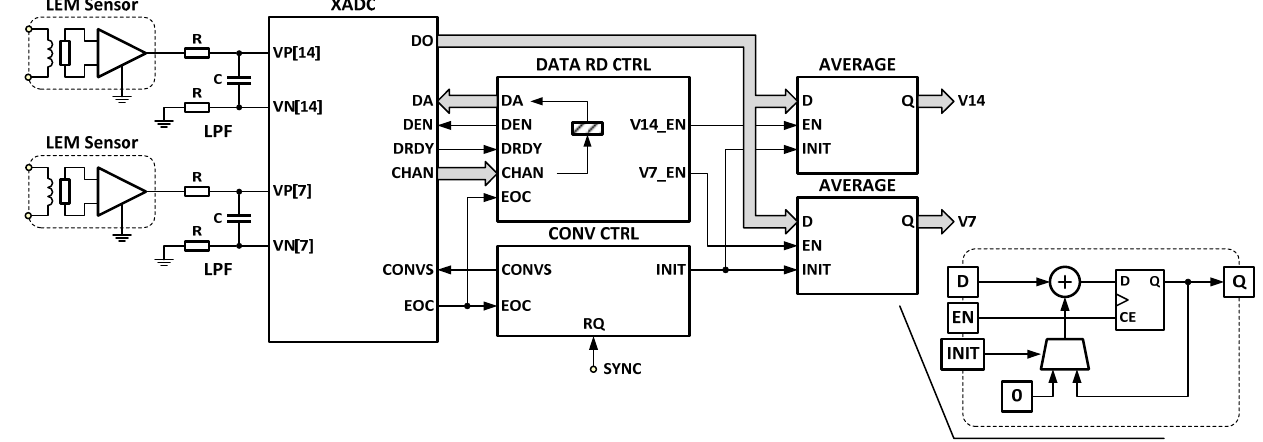
Figure 6. Windings current measurement unit based on integrated XADC.